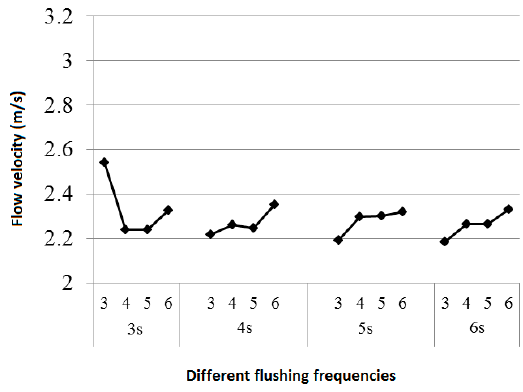
Figure 29. Flow velocity comparison of all frequencies when the slot nozzle is set at the bottom of the pipe.